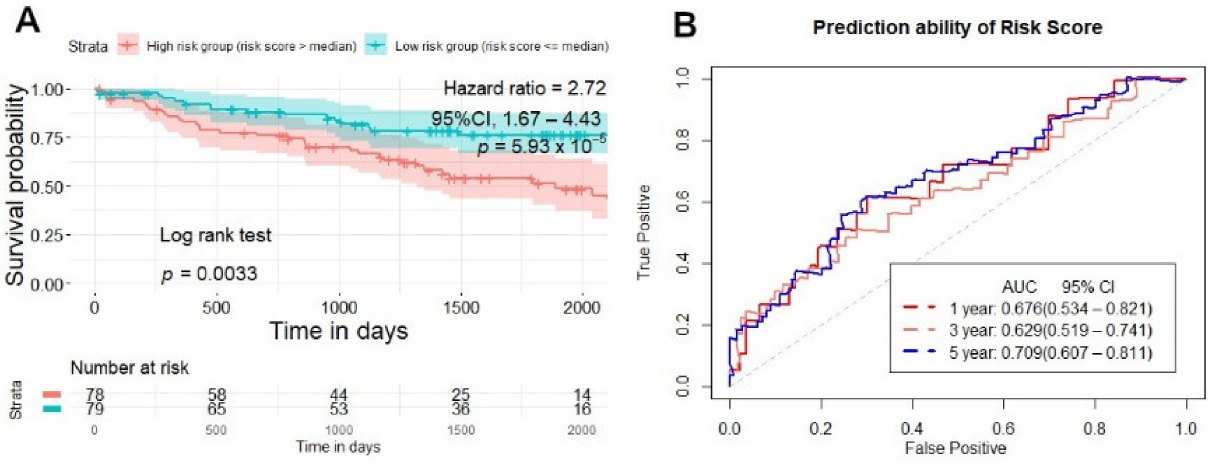
Figure 7. Survival prediction of risk score generated from CT-based radiomics signatures in the validation set. ( A ) Kaplan– Meier curves stratified patients into two groups: high and low-risk group by risk score in the validation set. ( B ) ROC curves illustrate the prediction ability of risk score for overall survival prediction in 1, 3, 5 years in the validation